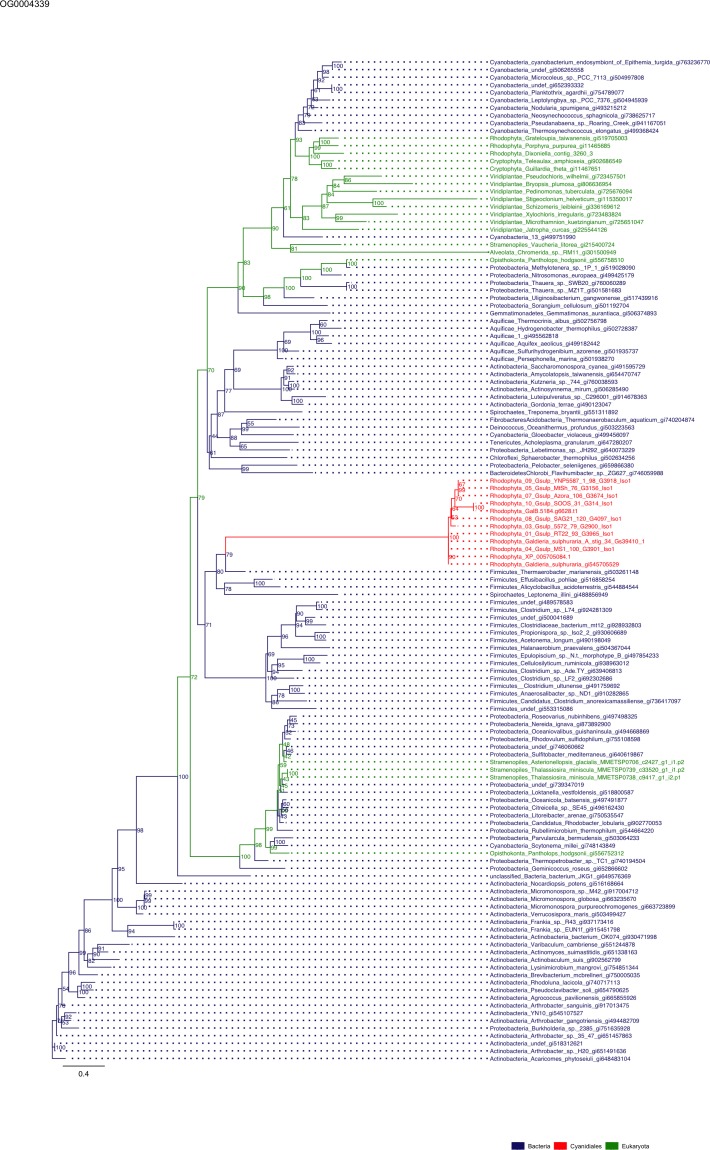
Sequence tree of orthogroup OG0004339.The tree is based on amino acid sequences. Archaea (yellow), Bacteria (blue), Cyanidiales (red), Eukaryotes including other red algae (green). Branches containing Cyanidiales sequences are highlited in red.